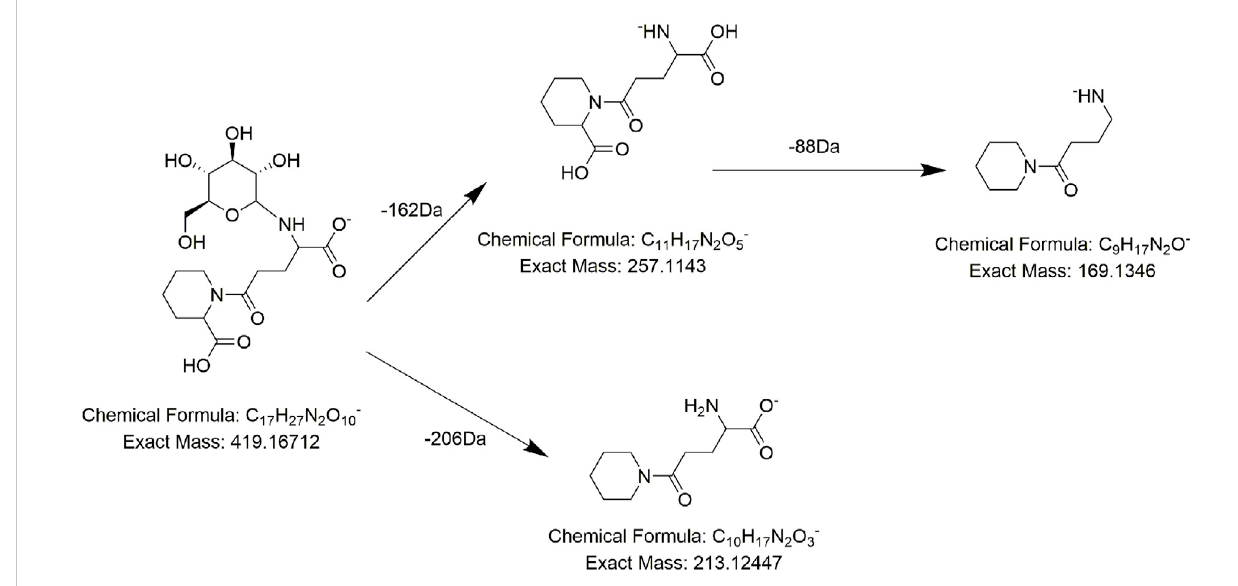
FIGURE 10 Proposed fragmentation pathways of AM7 (gamma-L-glutamyl-L-pipecolic-acid glucopyranoside).